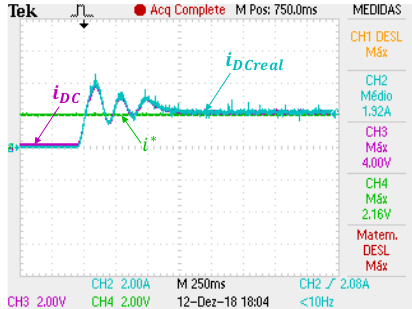
Figure 14. Experimental results of the proposed SAPF with reduced dc-link during the dc-link current regulation: Reference current, i *; Dc-link current, i DC